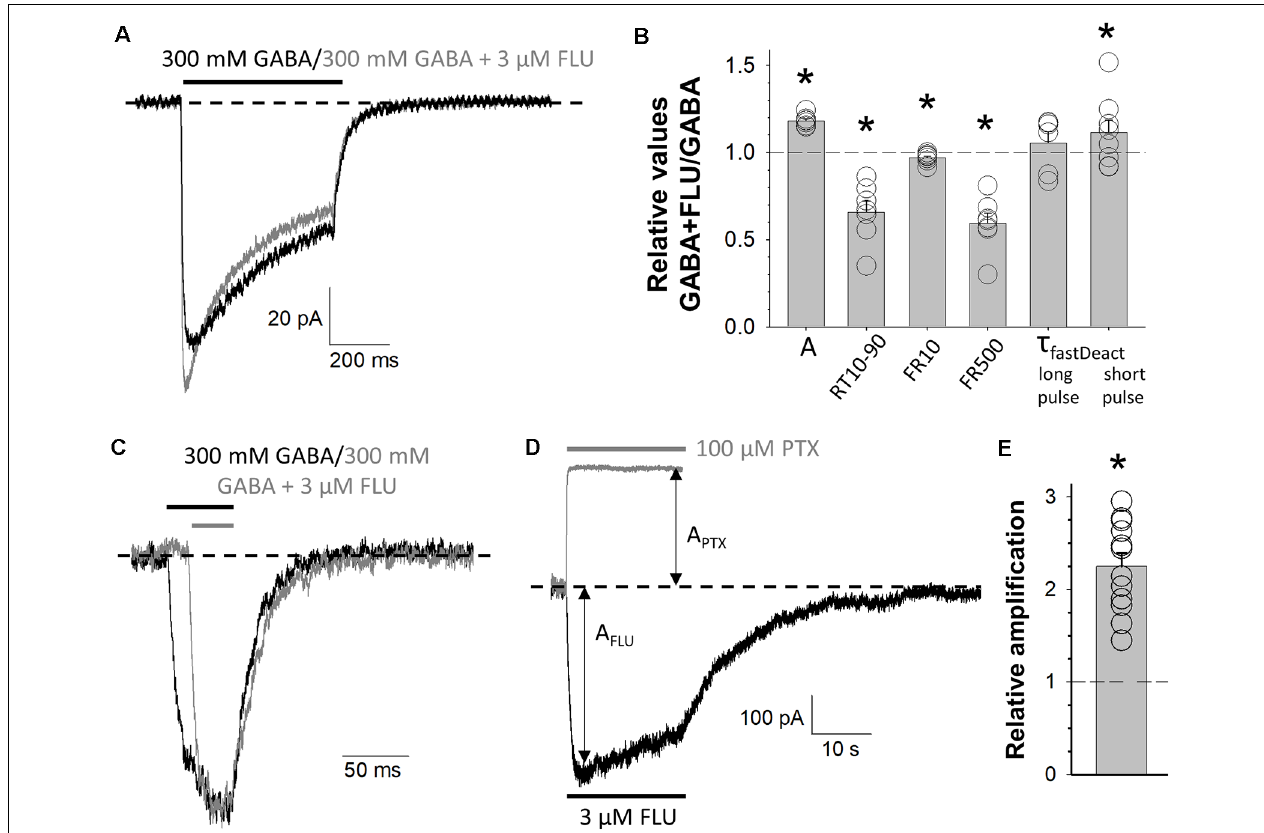
FIGURE 4 | Modulation of mutated receptors (MUT) by 3 µ M of flurazepam (FLU). Typical traces of MUT-mediated current responses evoked by 300 mM GABA (black) and 300 mM GABA + 3 µ M FLU (gray) for long (A) and short (C) application where the baseline level is marked with a dashed line. (B) Statistics for relative values (300 mM GABA + 3 µ M FLU vs. 300 mM GABA): A—amplitude of currents, RT 10–90—current onset, FR10—fraction of current remaining after 10 ms from peak, FR500—fraction of current remaining after 500 ms from the beginning of agonist application, τ fast —time constant of the fast component of